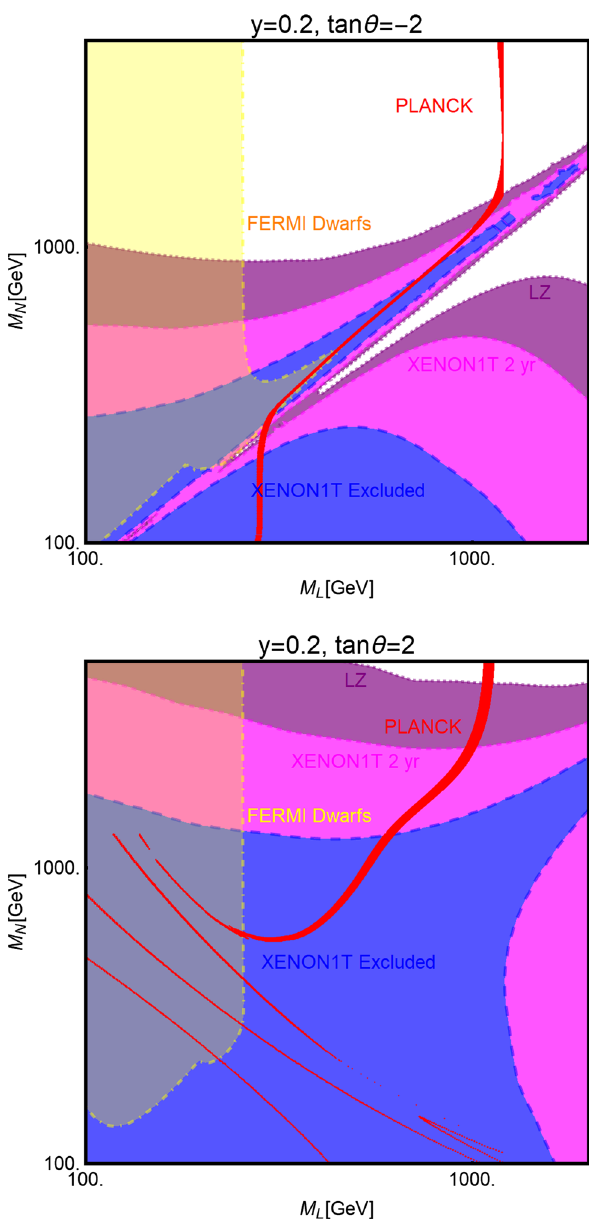
Fig. 27 SummaryoftheconstrainsfortheSinglet-Doubletmodelwith a Majorana fermion DM in the bi-dimensional plane ( M L , M N ) by tak- ing y = 0 . 2 and tan θ = − 2 (top panel) tan θ = 2 (bottom panel). The redlinesaretheiso-contourscorrespondingtothecorrectDMrelicden- sity. The blue, magenta and purple regions correspond to, respectively, the excluded region by XENON1T and the projected sensitivity regions of XENON1T itself, accounting for 2 years of exposure, and LZ. The yellow regions with yellow dashed-line boundary is excluded by DM ID from Fermi-LAT satellite